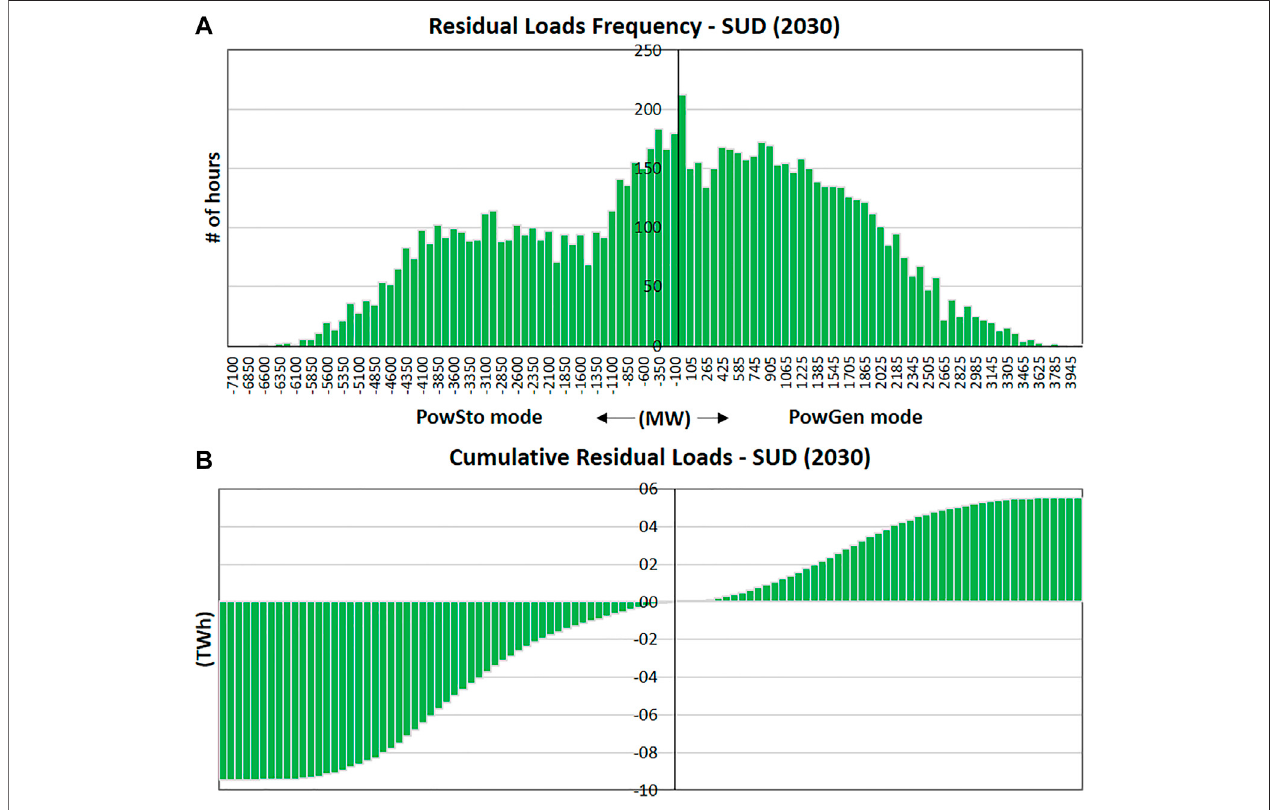
FIGURE 10 | Frequency histogram of the hourly PowGen/PowSto power capacity (A) . Energy content of waste and residues needed to support W2G technology deployed in the vRES-dominated zone (B) . 2030 scenario in Southern Italy (SUD zone).